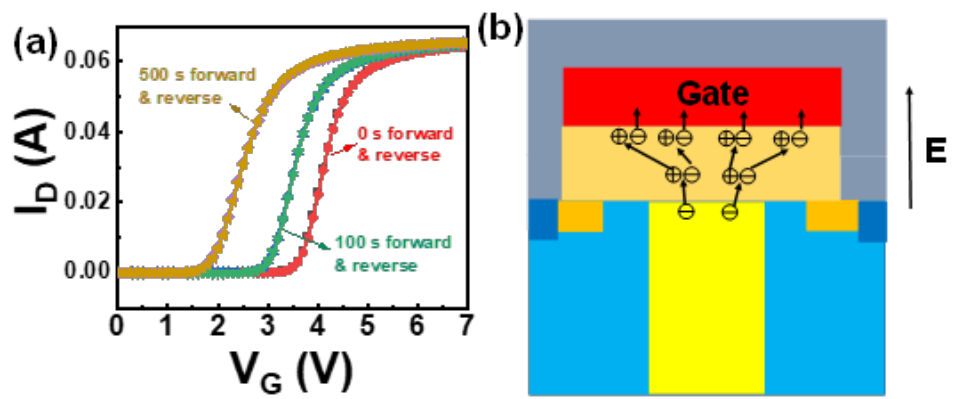
Figure 6. ( a ) Forward and reverse I D -V G curves after stress time of 0 s, 100 s, and 500 s with V D = 0.01 V. ( b ) Mechanism of device performance degradation.